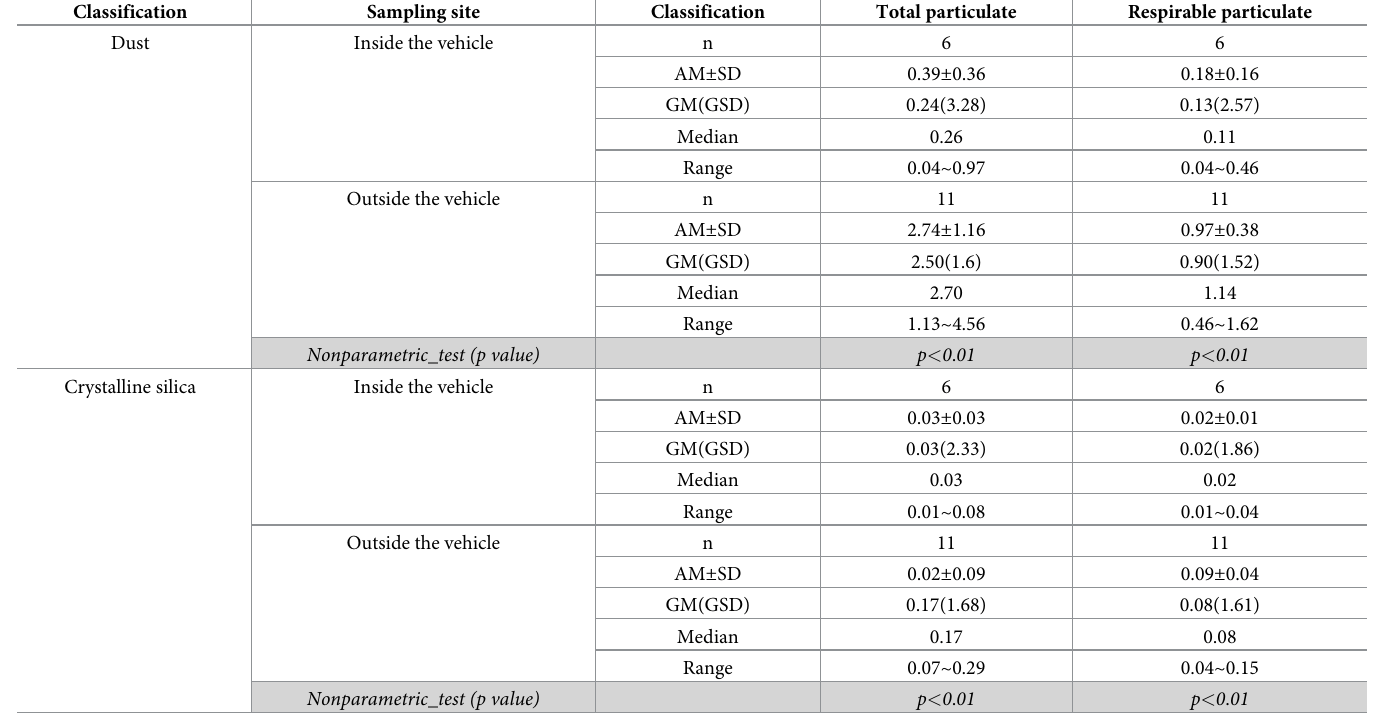
Table 6. Comparison of dust concentration and crystalline silica concentration in total particulate and respirable particulate in underground excavation work (unit: mg/m 3 ). Classification